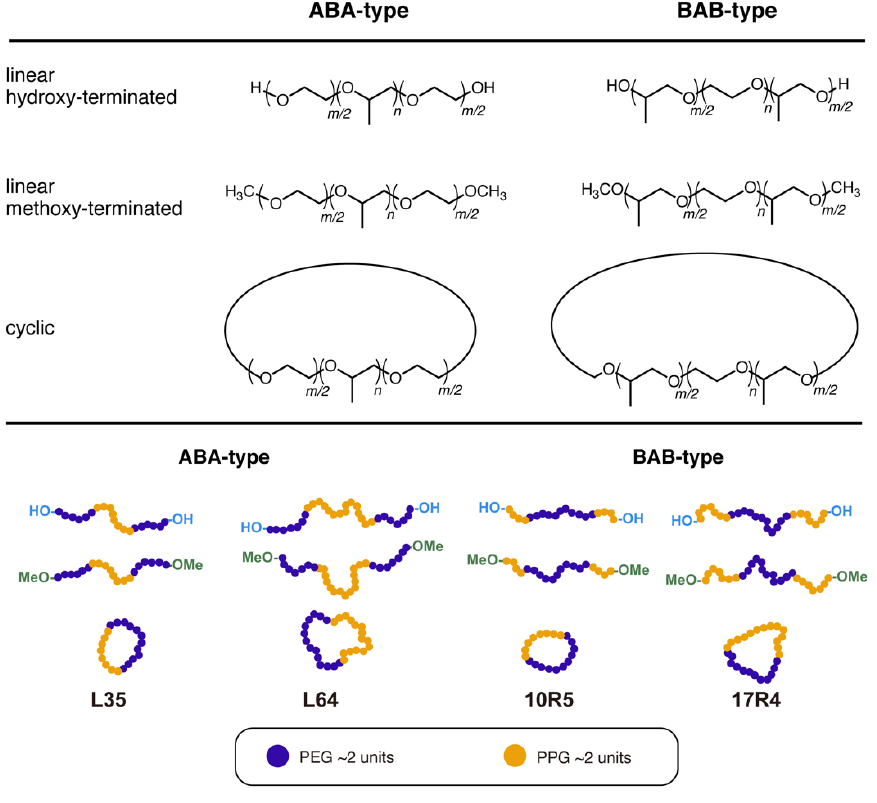
Figure 1. Chemical structures ( top ) and schematic illustrations ( bottom ) of various Pluronic copolymers used in this study. Both ABA- and BAB-type copolymers were compared to clarify the effect of cyclization in relation to their block sequence.